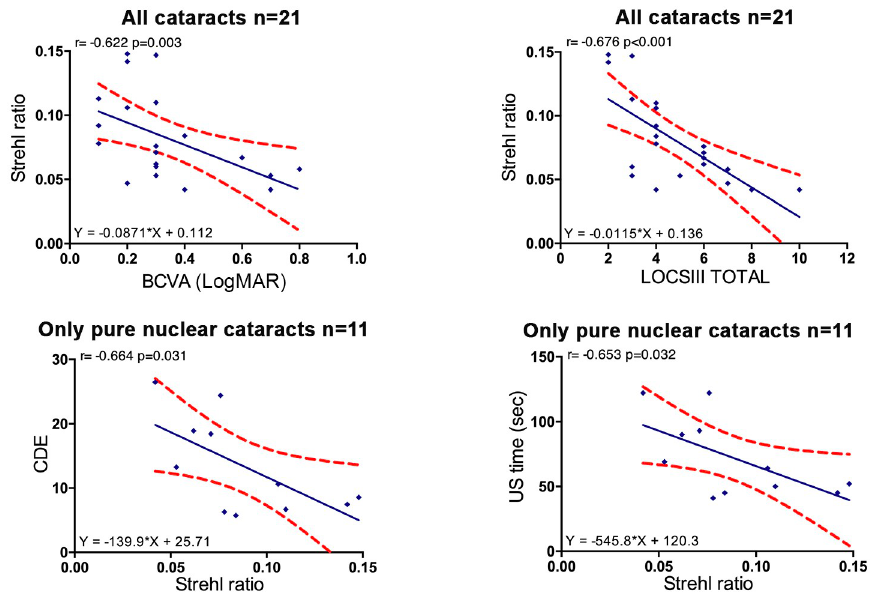
Fig 6. Linear regressions between Strehl ratio and clinical or surgical parameters. Red dots show the 95% CI of the slope and intercept. BCVA = far logMAR best-corrected visual acuity, LOCS III = lens opacity classification system III, CDE = cumulative dissipated energy, US = ultrasound.